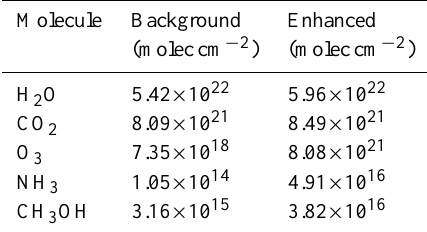
Table 1. Background and molecular amounts used in Fig.